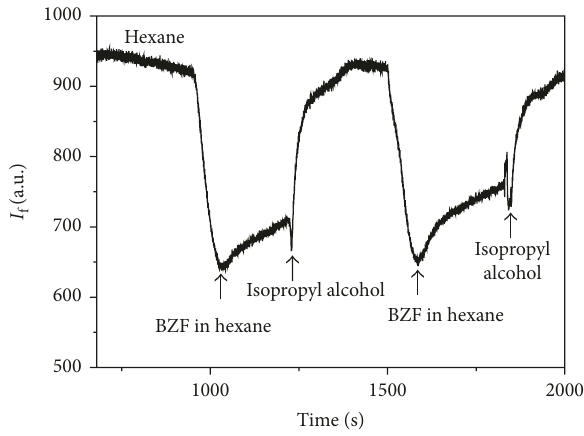
Figure 10: Fluorescence response profile for BZF remov- al/rebinding in a MIP.